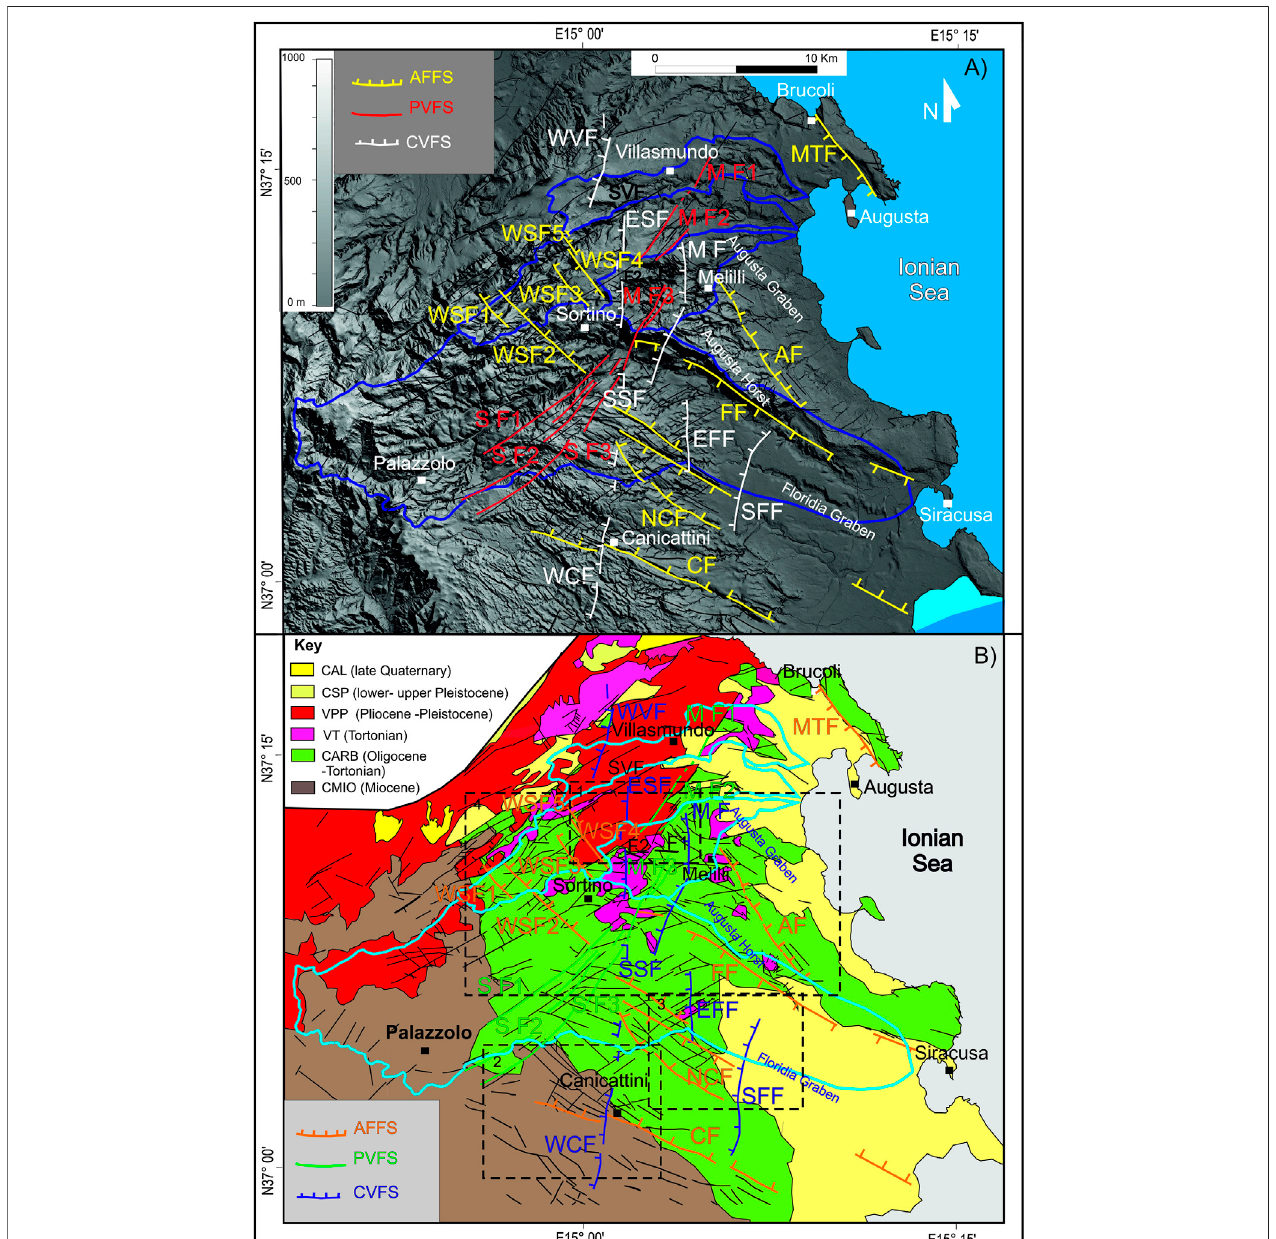
FIGURE 6 | (A) Mapped faults draped on the DEM. PVFS is the Palazzolo-Villasmundo Fault System: MF1, MF2 and MF3 are the Melilli Faults; SF1, SF2, and SF3 are the Sortino Faults. AFFS is the Augusta-Floridia Fault System: MTF is the Monte Tauro Fault; AF is the Augusta Fault; FF is the Floridia Fault; NCF is the North CanicattiniFault;CFistheCanicattiniFault.CVFSistheCanicattiniVillasmundoFaultSystem:WVFistheWestVillasmundoFault,ESFistheEastSortinoFault,MFisthe Melilli Fault; SSF is the South Sortino Fault, WCF is the West Canicattini Fault, EFF is the East Floridia Fault and SFF is the South Floridia Fault. F1 and F2 are minor faults;allminorfaultsarefromLentinietal.(1994).Bluepolygonsindicatethewatershedofthestudiedrivers. (B) Faultsandgeologicalformations;blackrectanglesrefer to the location of Figures 7 – 9 , 12 (rectangle 1, 2, 3, and 4 respectively).